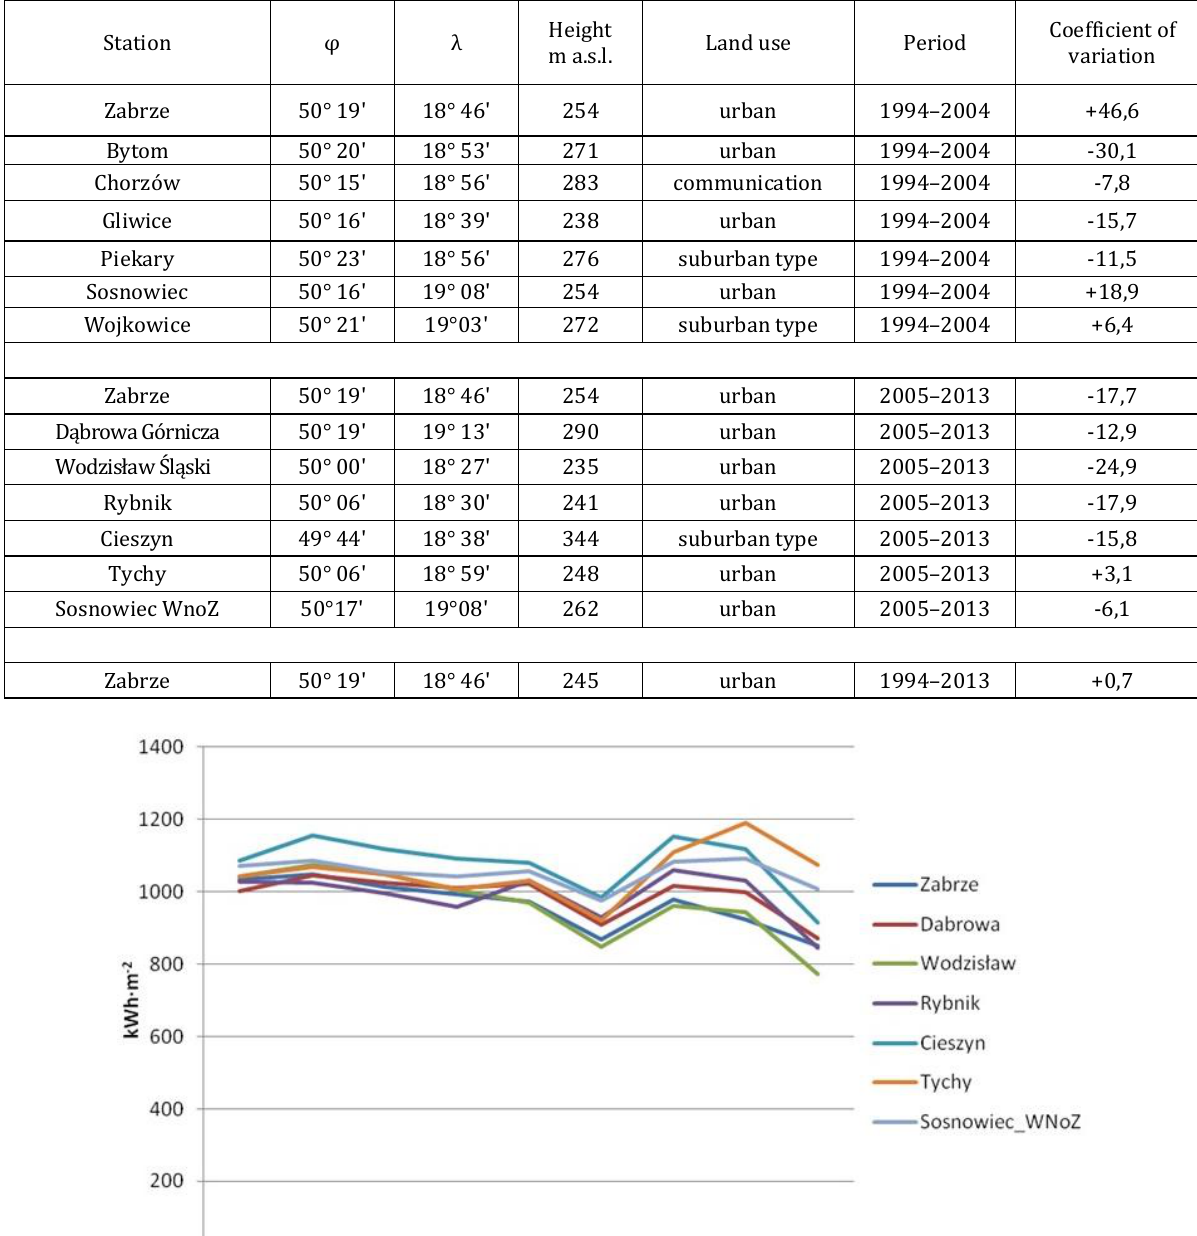
Table 1. Change in [%] in global solar radiation between 2004–1994 and between 2013–2005 Station